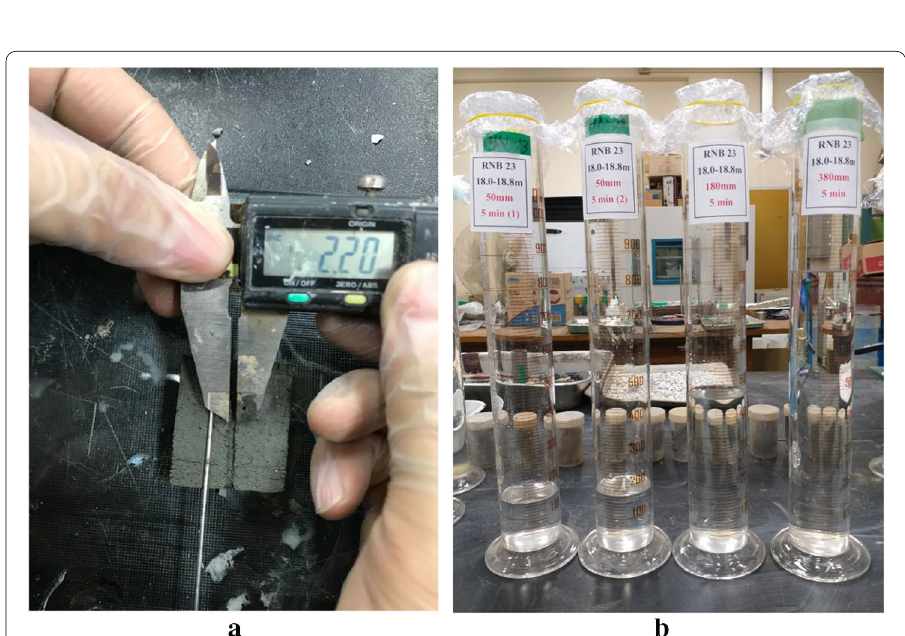
Fig. 10 a Hole size after test and b water collected from